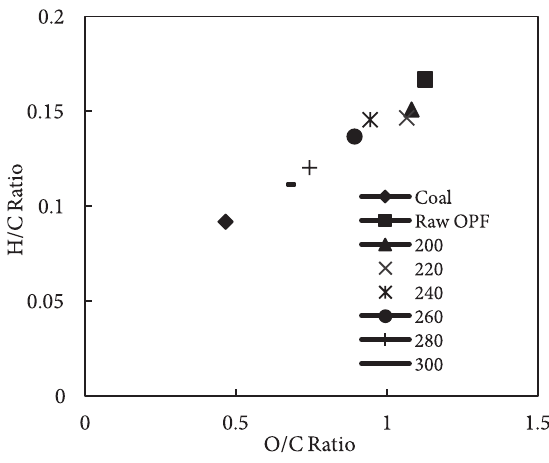
Figure 6. van Krevelen diagram of OPF